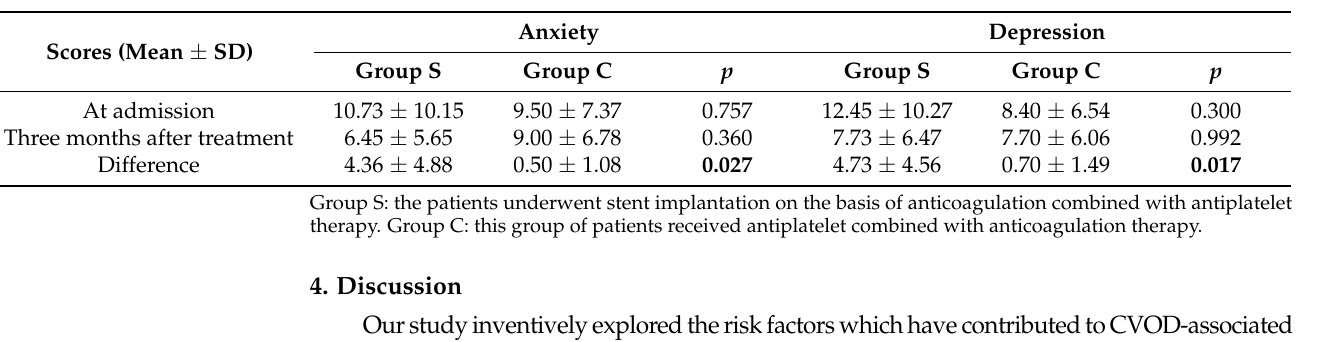
Table 5. Comparison of anxiety and depression scores between the stent group and the control group at 3 months after